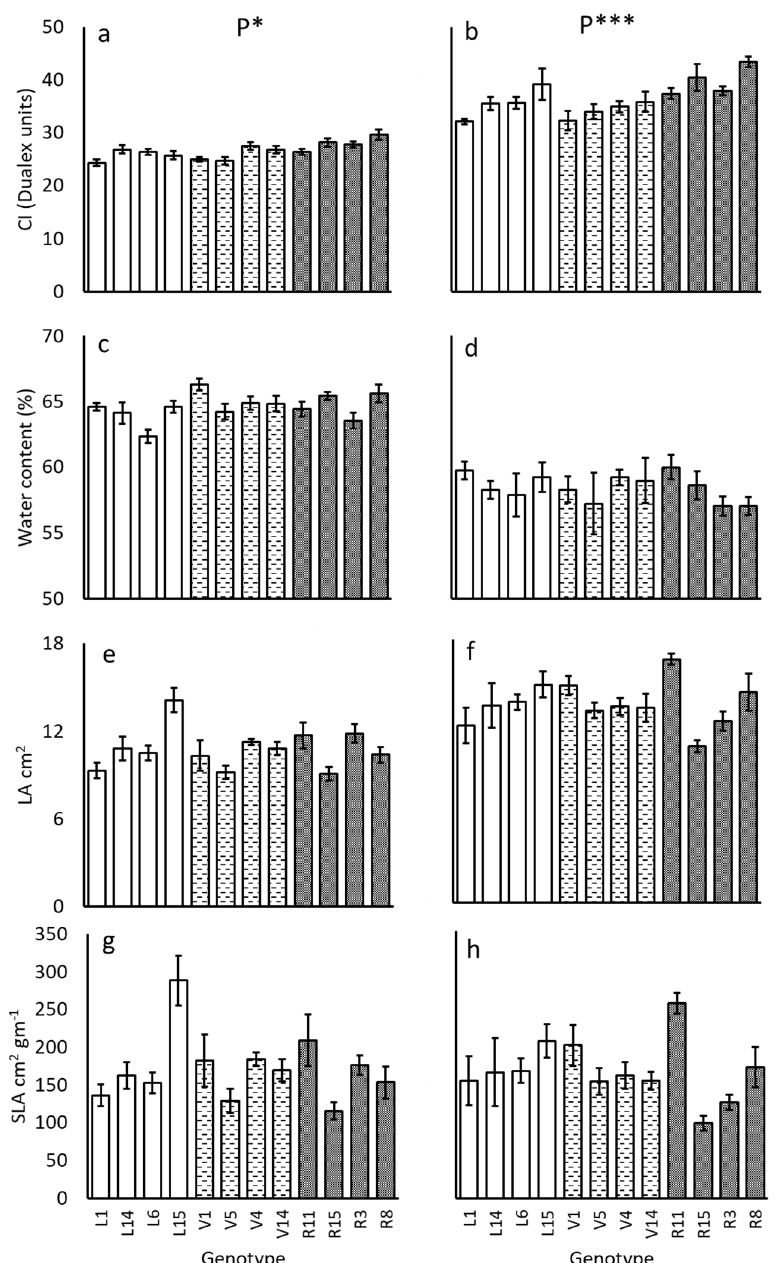
Figure 6. Leaf traits: ( a ) chlorophyll content index (CI (Dualex units)) in 2015 and ( b ) 2016, ( c ) water content in 2015 and ( d ) 2016, ( e ) leaf area in 2015 and ( f ) 2016, and ( g ) specific leaf area (SLA) in 2015 and ( h ) 2016; bar chart ( n = 9–11 for 2015 and n = 3 for 2016). Significant effects for genotype within provenance (G) and provenance (p) tested by linear mixed model with p as a fixed factor and G as the random factor (significant p values are denoted as *** ( p < 0.001), ** ( p < 0.01), * ( p < 0.05)) in the figures.